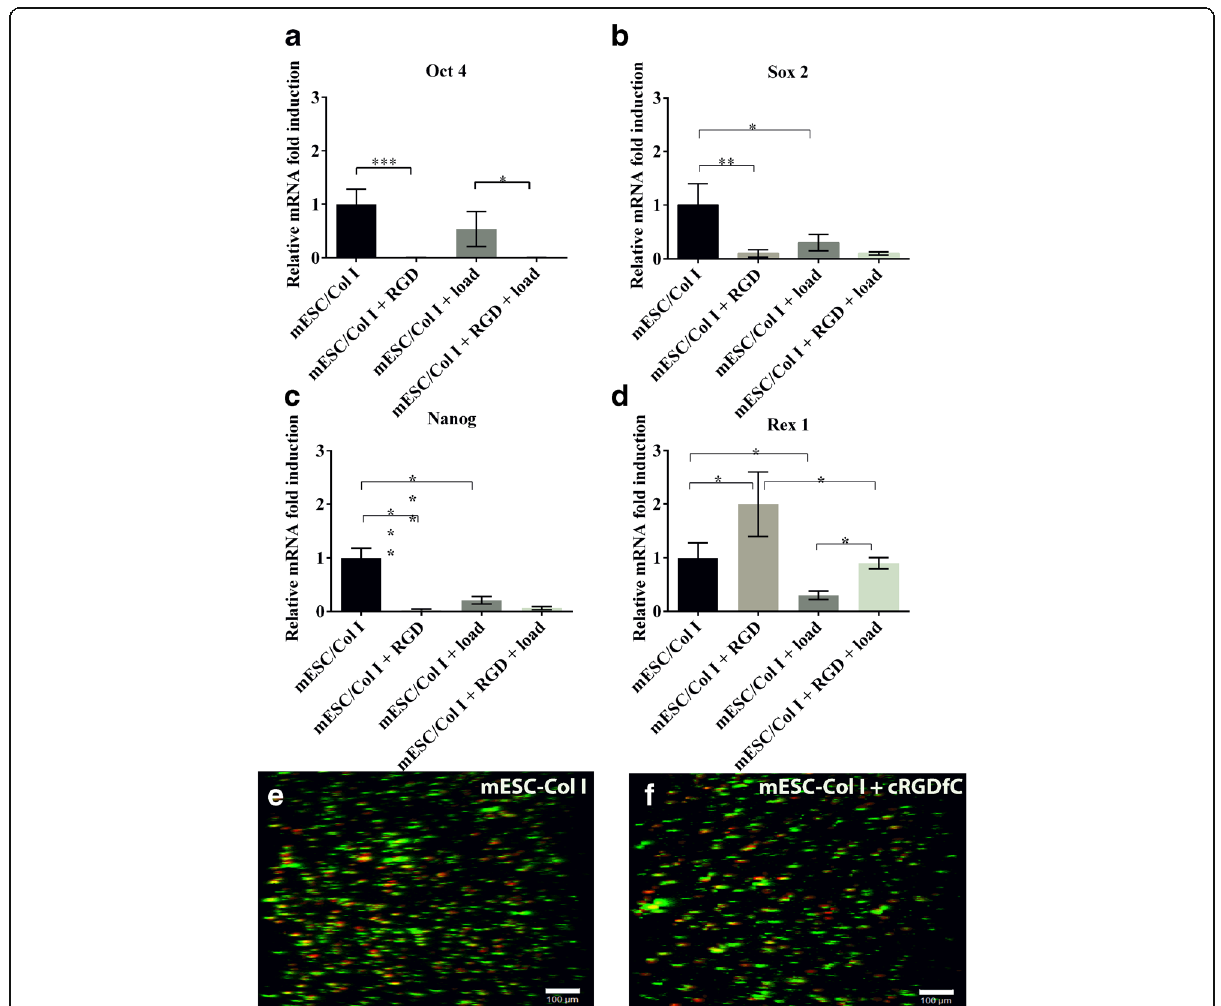
Fig. 1 The presence of cRGDfC peptide with and without compression down-regulated mESC pluripotent markers such as ( a ) Oct 4, ( b ) Sox 2 and ( c ) Nanog, while ( d ) Rex 1 gene expression was up-regulated. Application of compressive force on mESC-Col I constructs with free integrin receptor resulted in the down-regulation of all tested pluripotent markers. Mean ± SD, n = 3. (***; p < 0.0001; **; p < 0.001; *; p < 0.05). Z-stack images showing that cell viability in the presence and absence of cRGDfC was not significantly different ( e ) mESC-Col I, 83% ± 7 and ( f ) mESC-Col I + cRGDfC, 75.3% ± 2.5, Scale bar = 100 μ